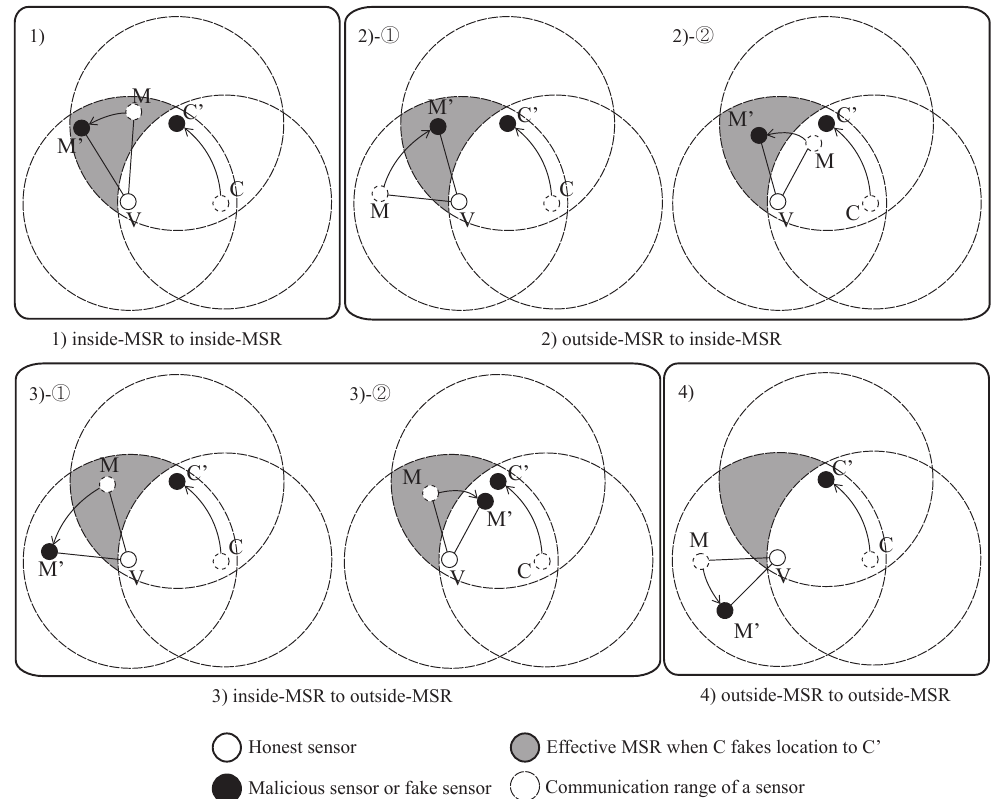
Figure 10. The effect of a malicious neighbor on D-filtering between honest and malicious